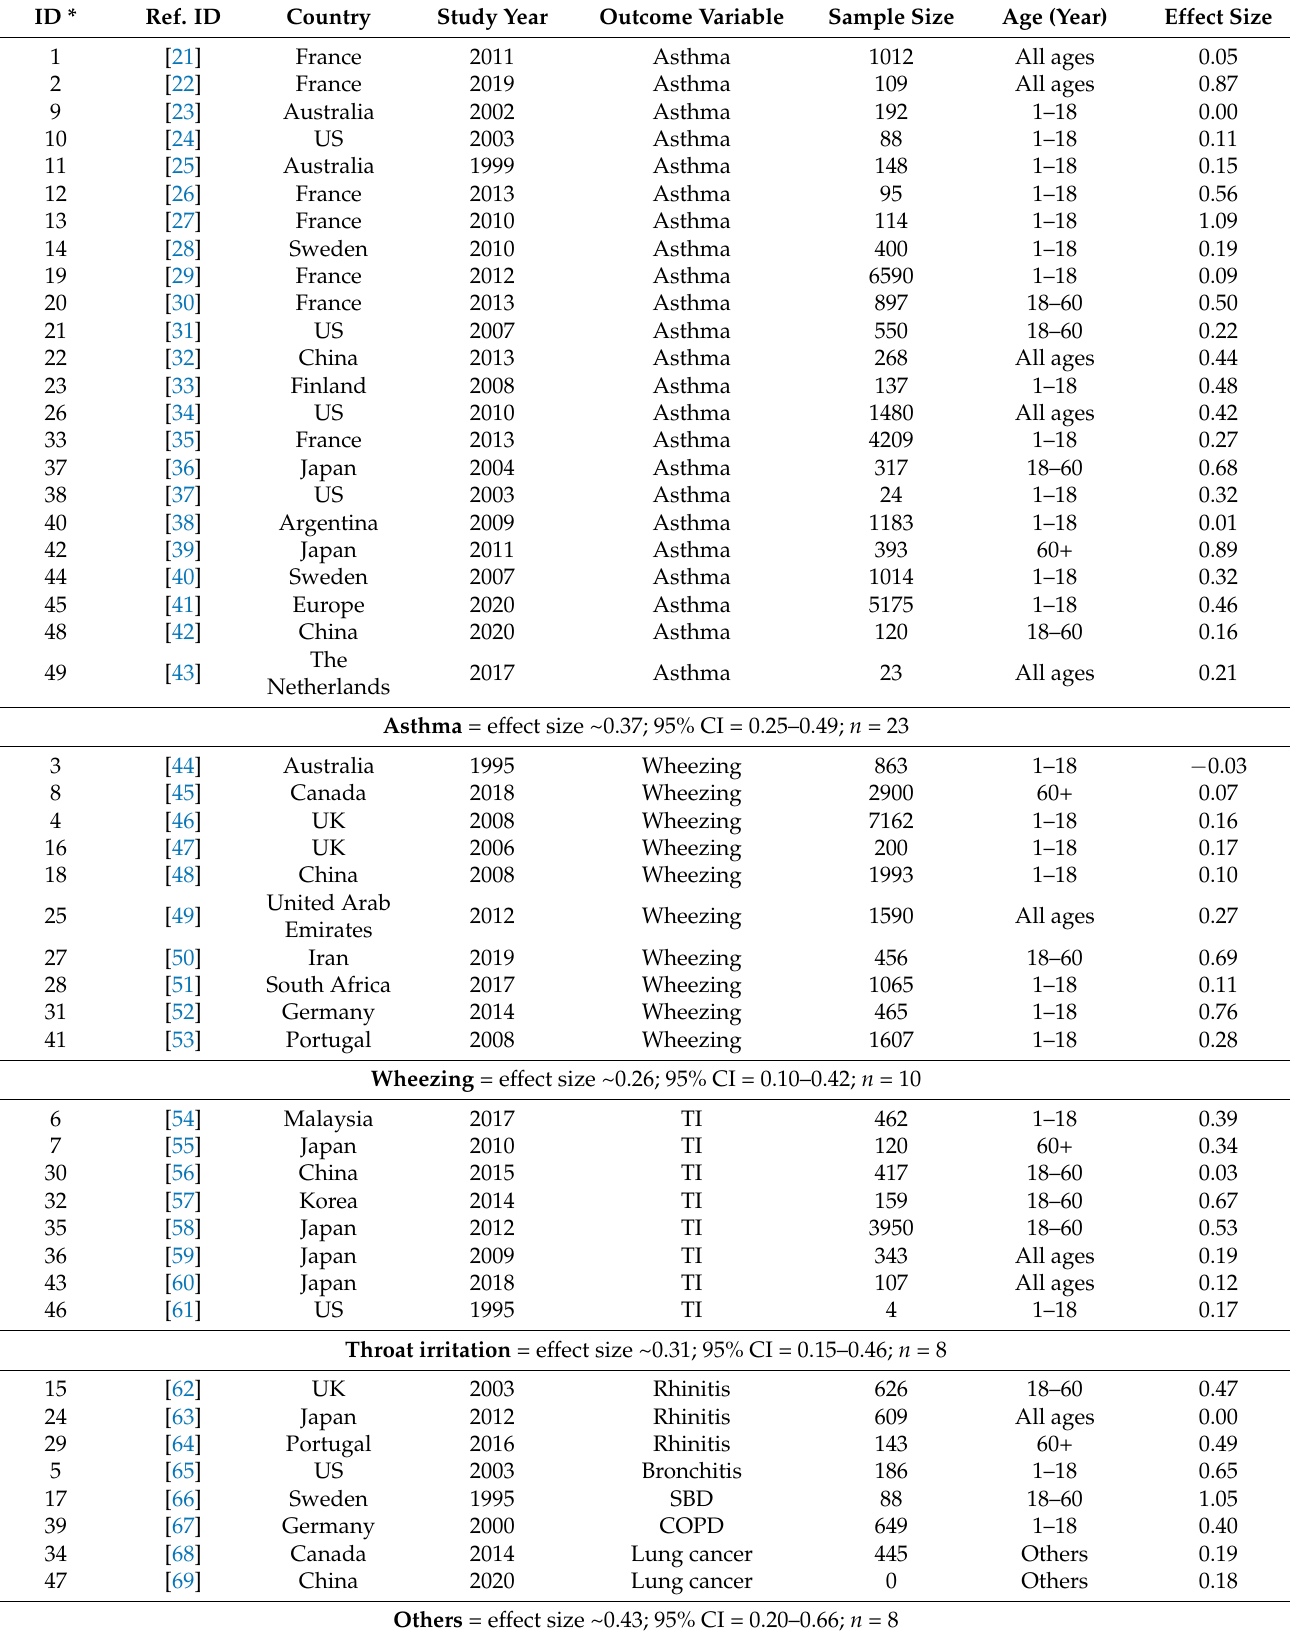
Table 2. List of studies included in the meta-analysis. (TI = throat irritation; SBD = sleep breathing disorder; US = United States; UK = United Kingdom; COPD = chronic obstructive pulmonary diseases; all ages: no specific age break up was